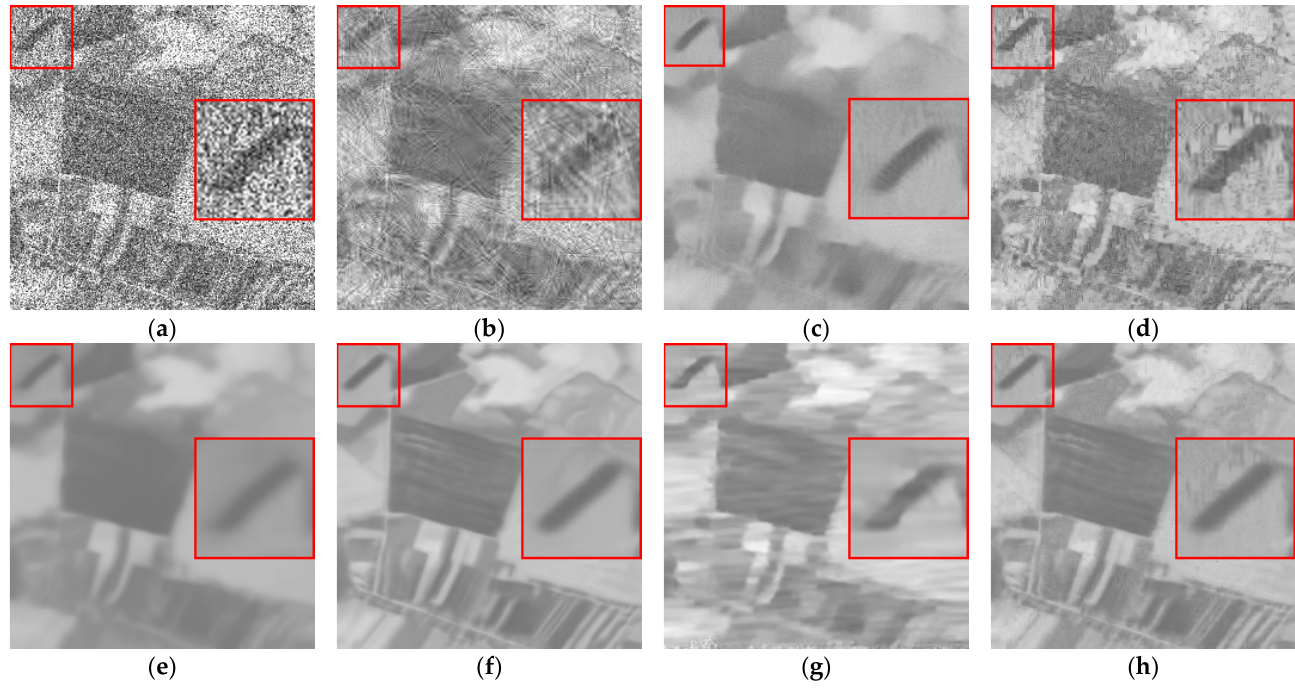
Figure 13. The results of all filters on RS1. The red box highlights the zoomed region of interest. ( a ) Noisy image; ( b ) W-C; ( c ) PPB; ( d ) SAR-BM3D; ( e ) H-WNNM; ( f ) GNLM; ( g ) FANS; ( h ) Proposed method.